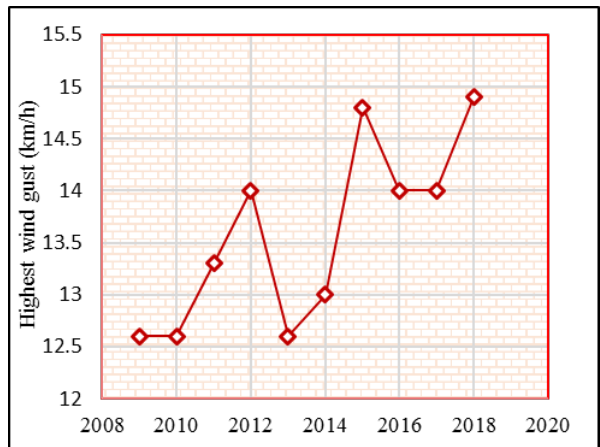
Figure 11. Annual Peak Wind Gust. Source: (NIMET 2018) The graph in figure 11 shows the annual peak wind gust over the last decade. In the first five years, the average annual Peak wing gust was 13km/h but has increased to 14.1km/h in the last five years with 2015 and 2018 having the highest annual peak of 14.8 and 14.9